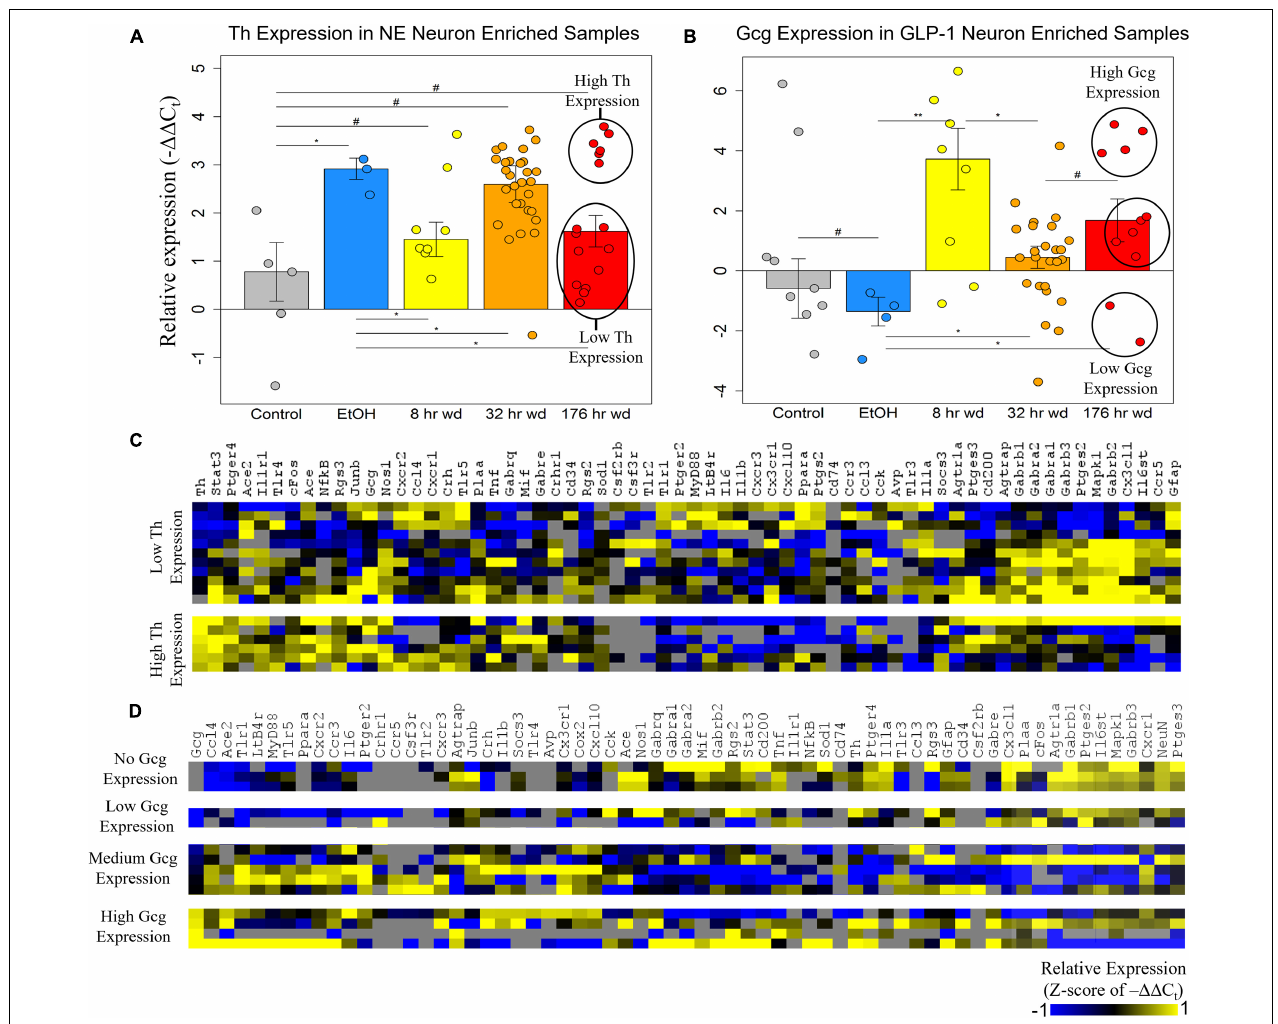
FIGURE 2 | Neurotransmitter Expression in Neurons. ** p < 0.003 * p < 0.05, # p < 0.1; two-tailed heteroscedastic t -test. Bars show standard error. (A) Tyrosine hydroxylase expression (Th) in norepinephrine (NE) neuron enriched samples. Bimodal Th expression at the 176 h wd time point is explored in the heat map in panel (C) . (B) Preproglucagon (Gcg) expression in GLP-1 neuron enriched samples. Trimodal Gcg expression at the 176 h wd time point is explored in the heat map in panel (D) . (C) Heat map exploring high Th-expressing neurons and low Th-expressing neurons as subclusters of NE neuron enriched samples in the 176 h wd treatment. Single-cell gene expression is shown as z-scores of – (cid:49)(cid:49) C t values. Neurotransmitter expression levels does not determine high-template co-expression gene clusters. (D) Heat map exploring high, middle, and low Gcg-expressing neurons as subclusters of GLP-1 enriched neuronal samples in the 176 h wd treatment. Single-cell gene expression is shown as z-scores of – (cid:49)(cid:49) C t values. Neurotransmitter expression levels does is more predictive of co-expression gene clusters than Th.